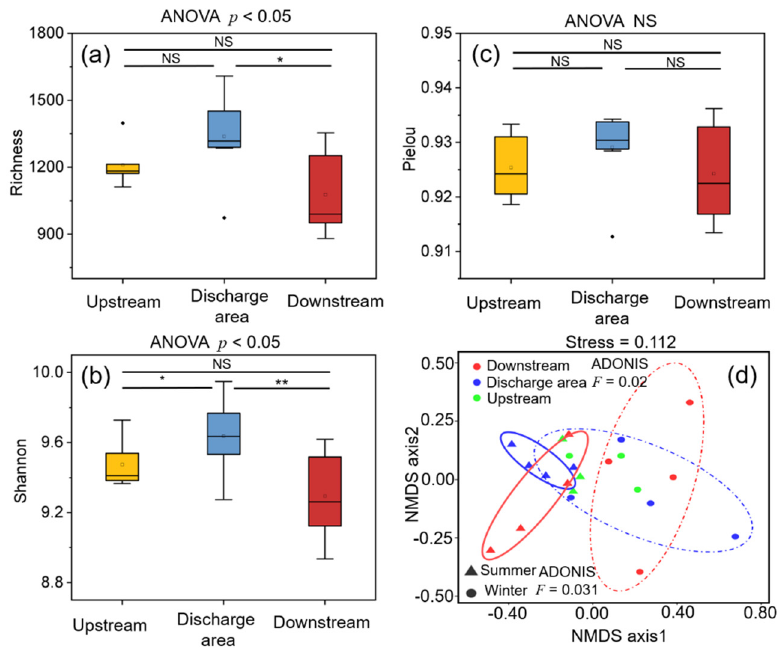
Figure 4. ( a – c ) Diversity of bacterial communities and mechanisms of assembly. Comparison of diversity indices in different areas. Asterisks represent the difference between two groups (* p < 0.05; ** p < 0.001; NS represents no significant difference) and p -values represent the overall group difference. ( d ) Non-metric multidimensional scaling (NMDS) analysis by areas and seasons; different colors represent different areas and different shapes represent different seasons.